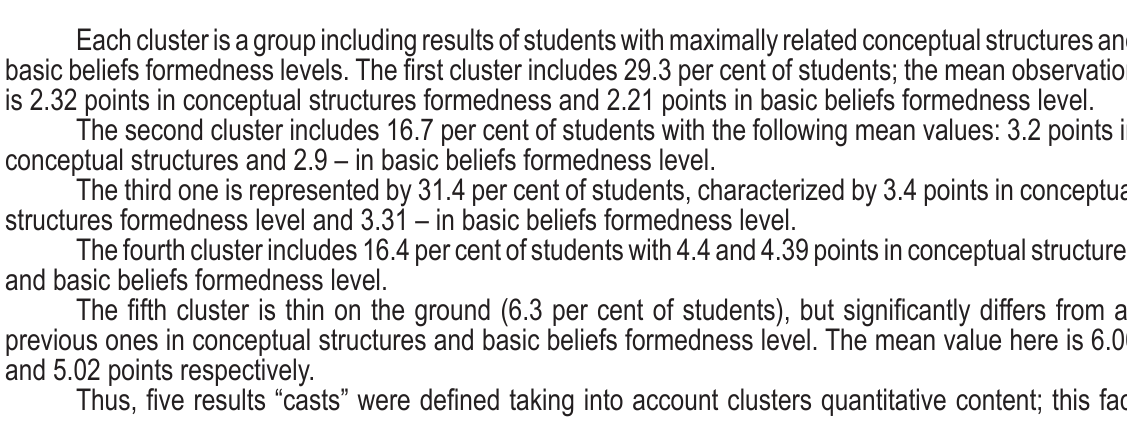
Figure 1. Tree diagram of the analysis results